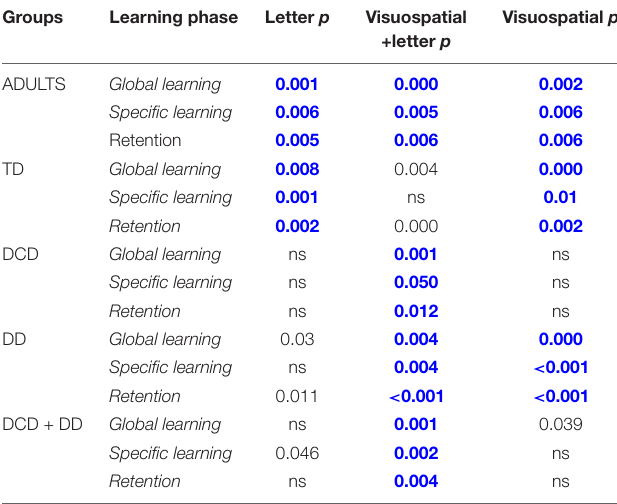
TABLE 2 | Results on global learning, specific learning, and retention for each group and condition.